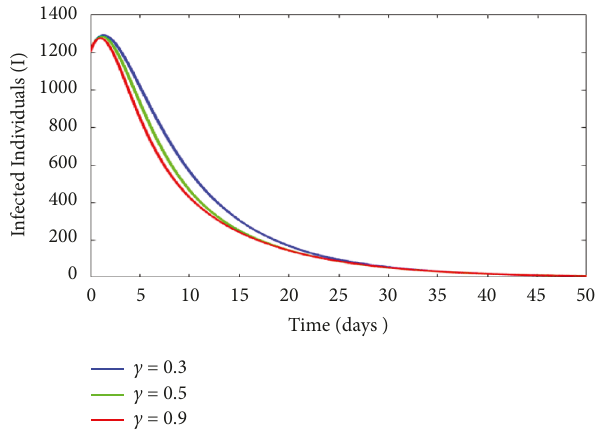
Figure 3: The effect of variation in the vaccination rate ( c ) on infection dynamics.